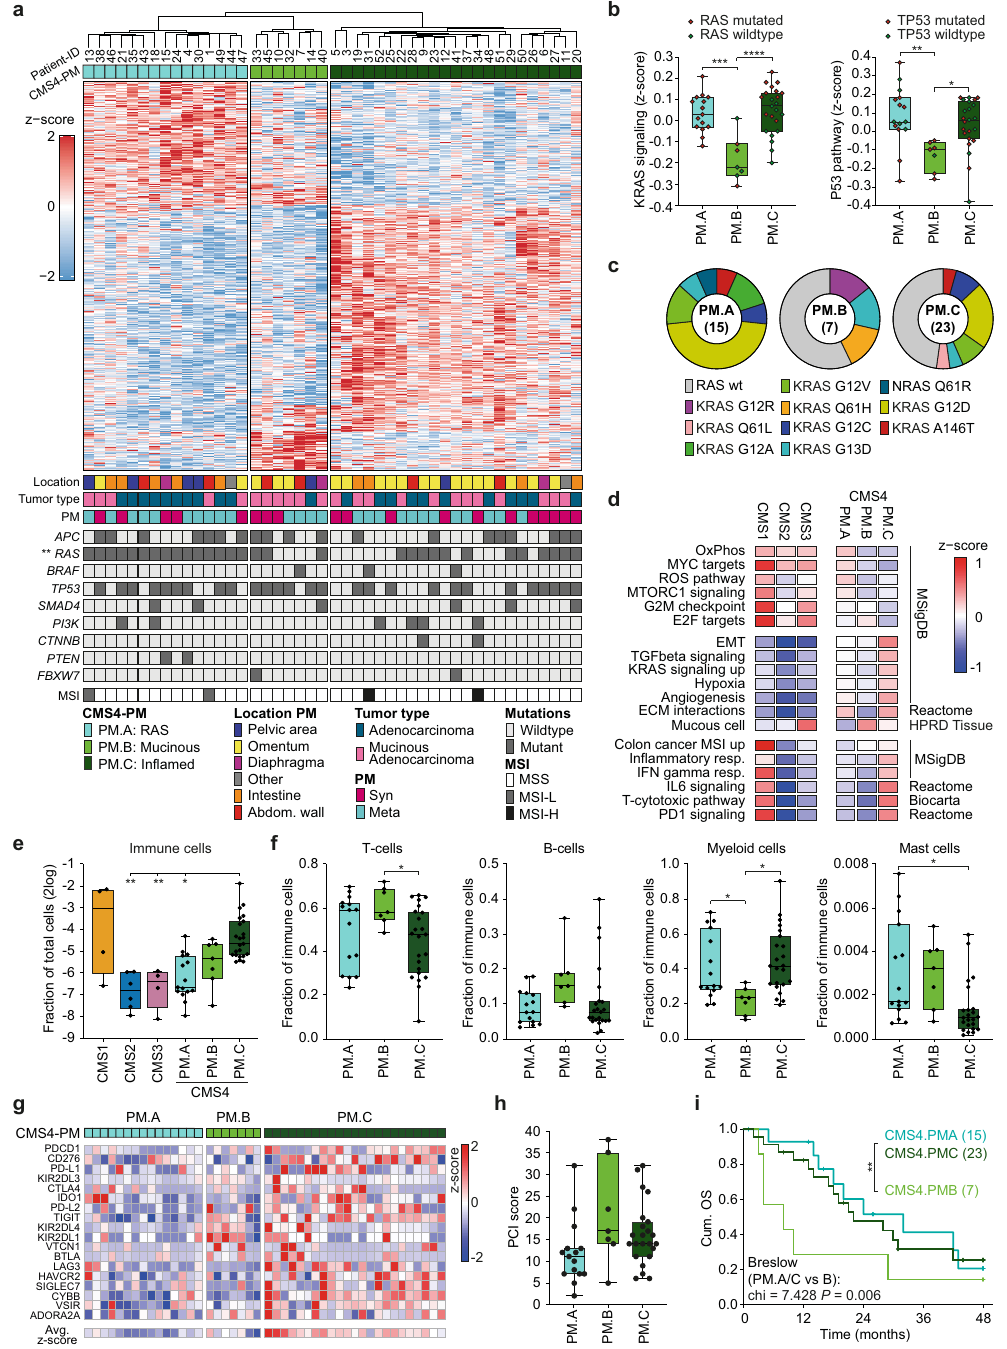
Fig. 3 | Clustering CMS4 peritoneal metastases into 3 distinct subgroups. a Heatmap depicting the 1355 most differential expressed genes between the 3 CMS4-PM subgroups (1 PM sample per patient, n =45), clustered by CMS4-PM subgroup. Location of lesions, primary tumor type, development of PM (syn- or metachronous),mutationalstatusofCRCdrivergenesandMSIareindicatedbelow (two-sided Fisher ’ s exact test). b Z-scores of KRAS(left) and TP53 (right) activation gene signatures in the CMS4-PM subgroups. Red and green dots indicate respec- tively mutated or wild-type genes (one-way ANOVA with Tukey ’ s multiple com- parisonstest,*** P =0.0001,**** P <0.0001,** P =0.0049,* P =0.0232). c Distribution of RAS mutations ( KRAS and NRAS ) over the 3 CMS4-PM subtypes. d Gene set enrichment analysis depicting differentially expressed ( P <0.05, two-sided t-test) signatures between the PM subgroups. Colors indicate relative signature expres- sion(z-score). e DeconvolutionofbulkRNAsequencingdatawasusedtodetermine the fraction of immune cells per sample (Welch ANOVA with Dunnett ’ s multiple